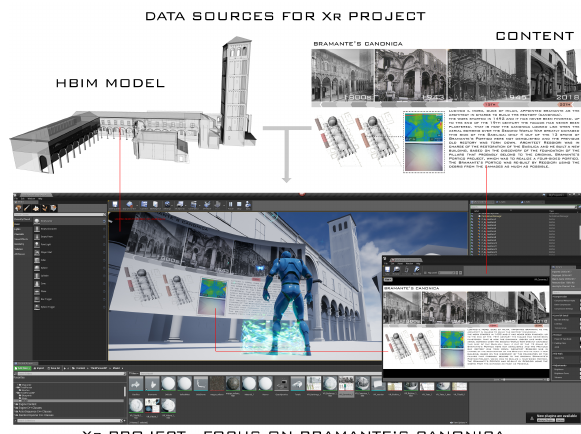
Figure 9. The HBIM model and the history of Bramante’s Canonica are connected in the Xr project.